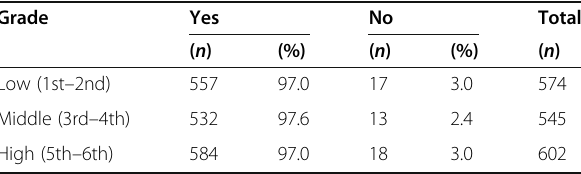
Table 5 Characteristics of “ Have close friends ” analyzed by stratified grade ( p =